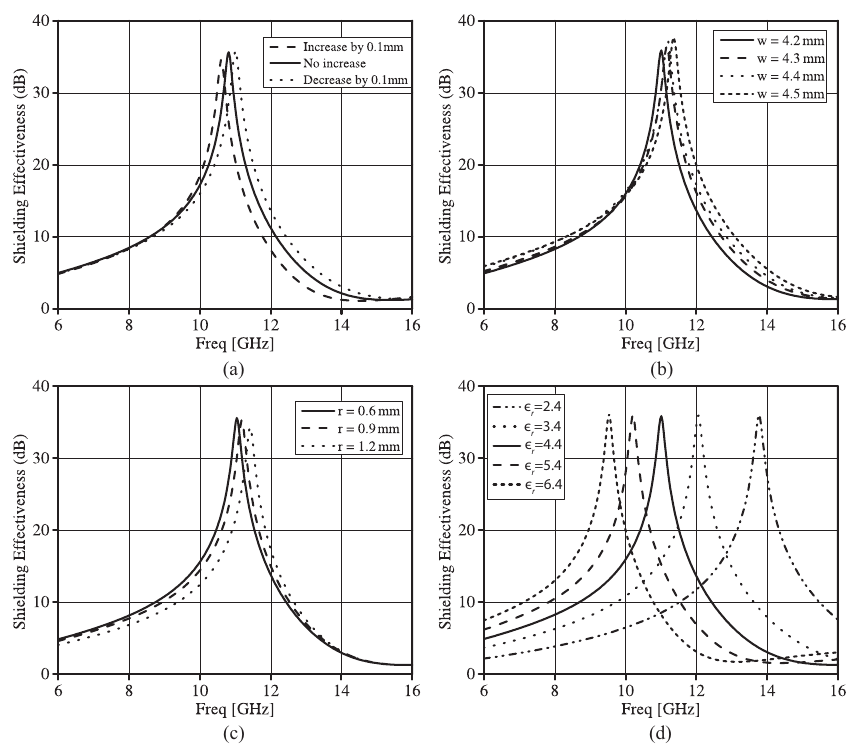
Figure 4. Parametric analysis of geometric parameters and their effects on f r by changing the ( a ) arms’ length l , ( b ) strip width w , ( c ) element spacing r , and ( d ) dielectric constant (cid:101) r